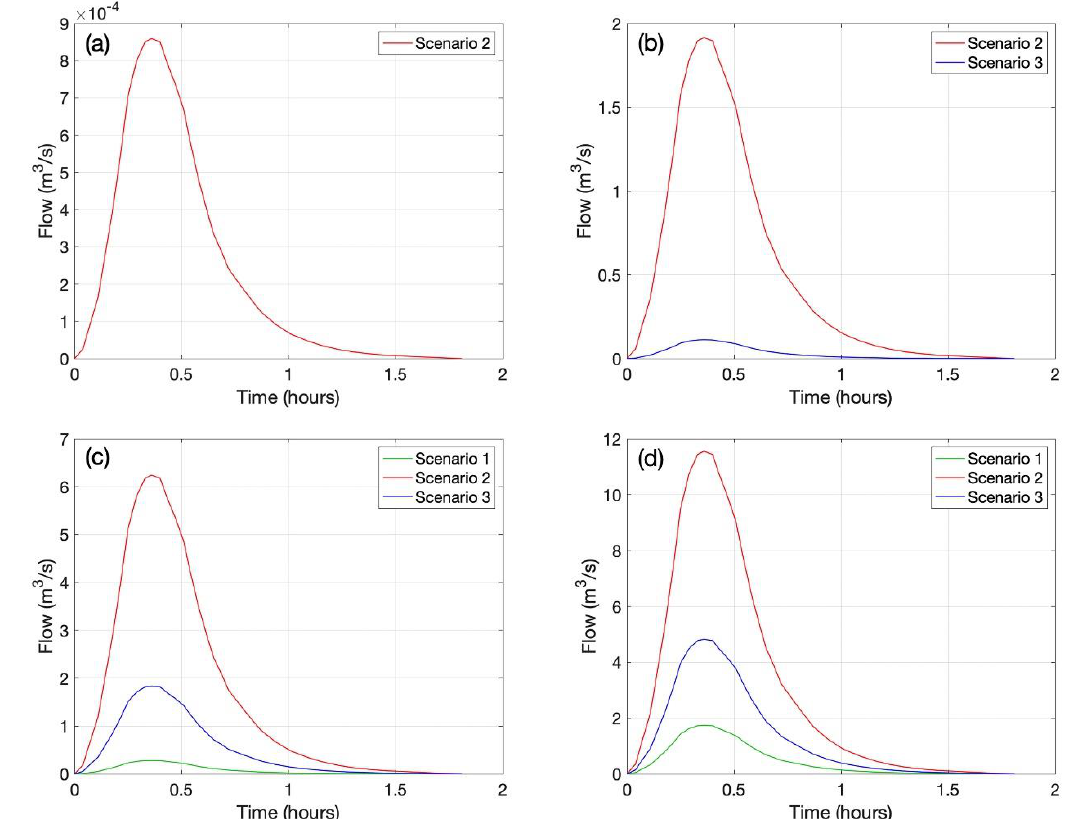
Figure 6. Design hydrographs for the simulated scenarios and return periods analyzed. ( a ) 𝑇 𝑟 =2 years; ( b ) 𝑇 𝑟 =5 years; ( c ) 𝑇 𝑟 =10 years; ( d ) 𝑇 𝑟 =20 years.